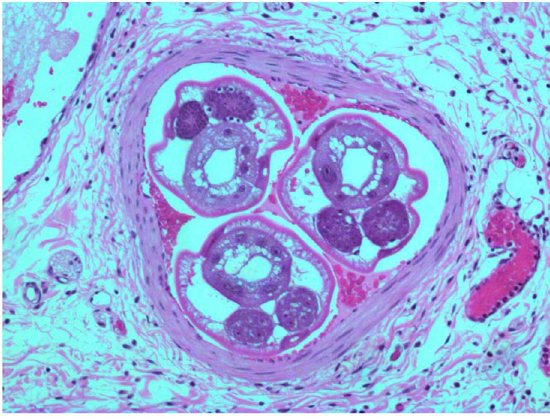
Figure 2. Larvae of Angiostrongyluscostaricensis (arrow) inside a granuloma in confirmed case (H&E, 100x).